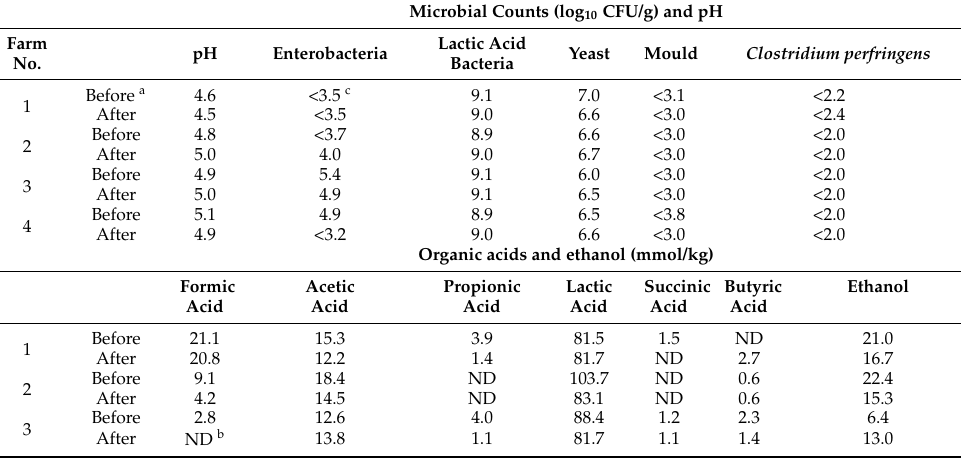
Table 7. Microbiological counts and organic acid and biogenic amine concentrations in liquid feed sampled from valves mid-way along the circuit of four farms before and after cleaning and disinfection of the entire liquid feeding system (adapted from Fisker and Jørgensen [30]). Microbial Counts (log 10 CFU/g) and pH Farm